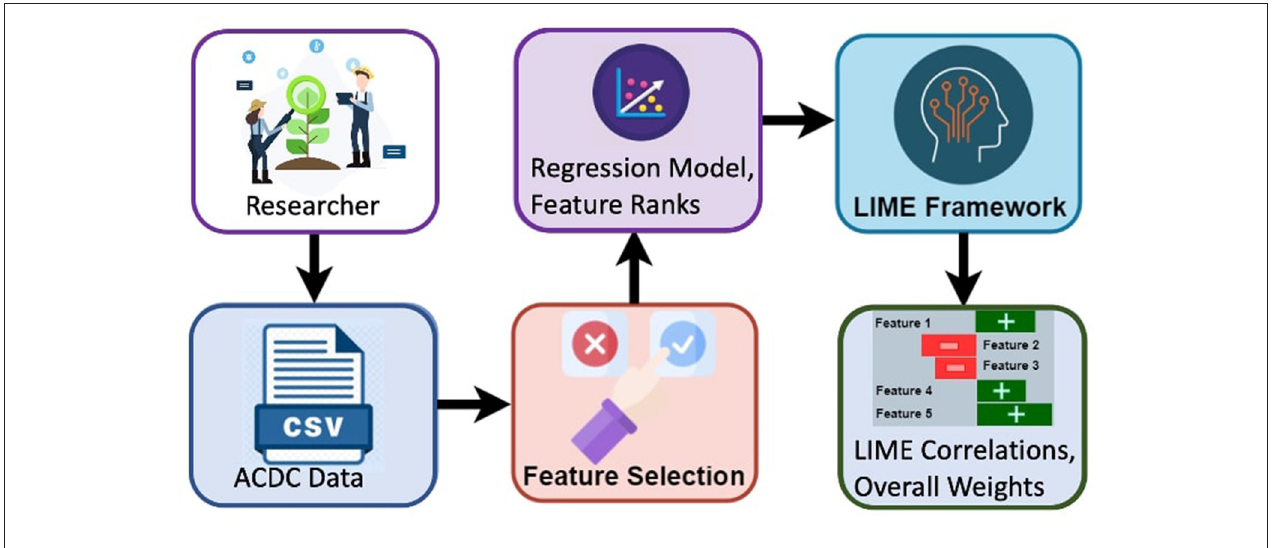
FIGURE 4 | Overview of explainable machine learning